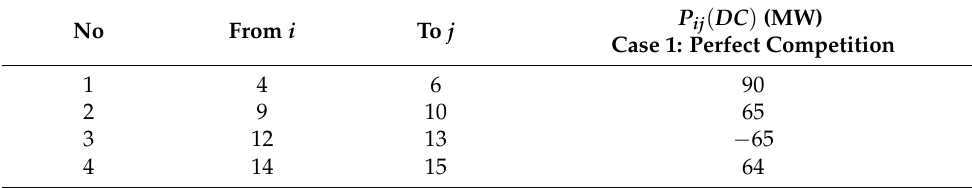
Figure 2. IEEE 30 bus test power system. Table 4. Congested transmission lines IEEE 30